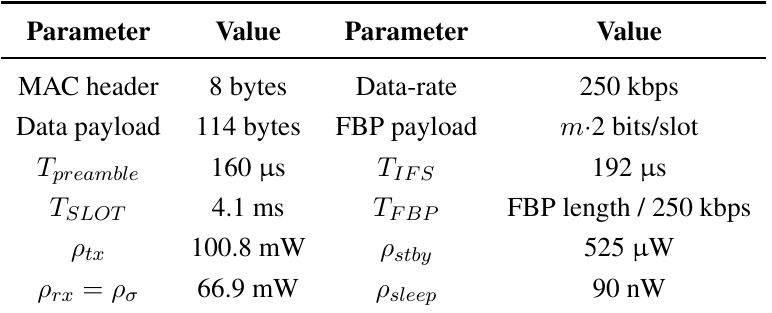
Table 1. System parameters. FBP, feedback